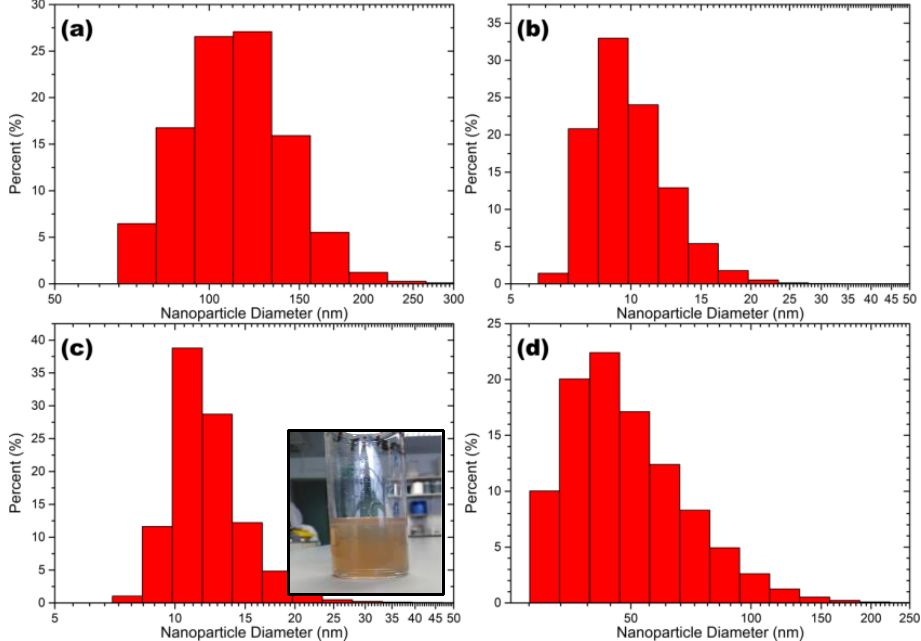
Figure 1. DLS nanoparticle size distributions for AgNPs produced via ( a ) USP, ( b ) commercial AgNPs (Sigma Aldrich), ( c ) recirculatory LASiS and ( d ) batch LASiS produced.